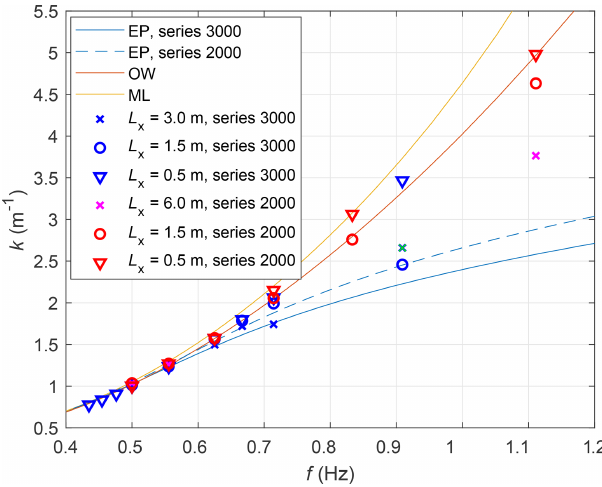
Figure 2. Wavenumber k (m − 1 ) in the experiments from LS-WICE series 2000 and 3000 together with corresponding wavenumbers from the elastic-plate (EP), open-water (OW), and mass loading (ML) dispersion relations (in the case of ML, the curves for both series are indistinguishable). The cross symbol shown in green cor- responds to test 3160, nominally with L x = 3 . 0m but with smaller actual floe size due to breaking. See Cheng et al. (2018) for more